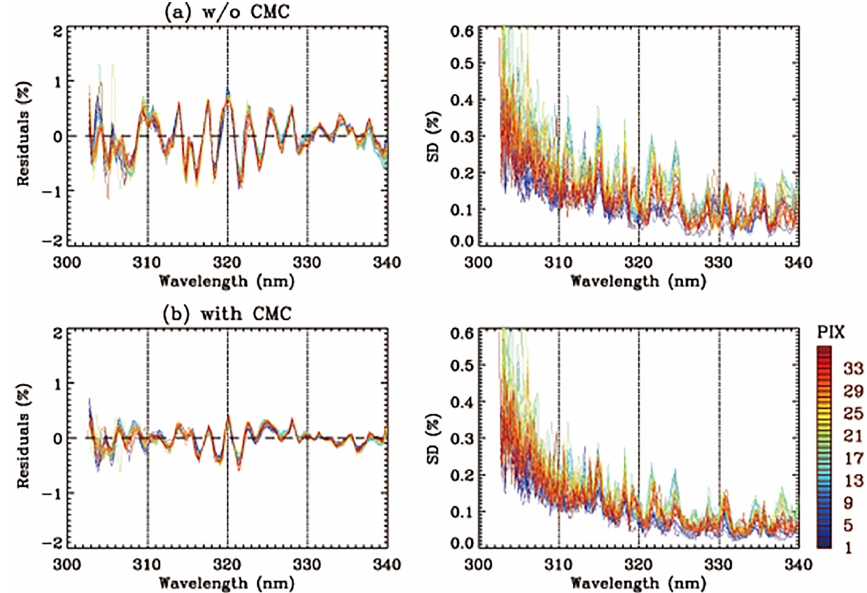
Figure 10. Comparisons of mean fitting residuals (%) and standard deviations (%) for latitude >60 ◦ with different cross-track positions in different colors for one orbit data (6962) on 2 March 2013, without (a) and with (b) common mode correction.